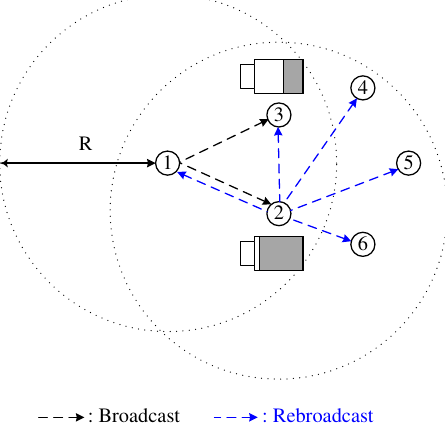
Figure 3. Battery-aware counter-based broadcast